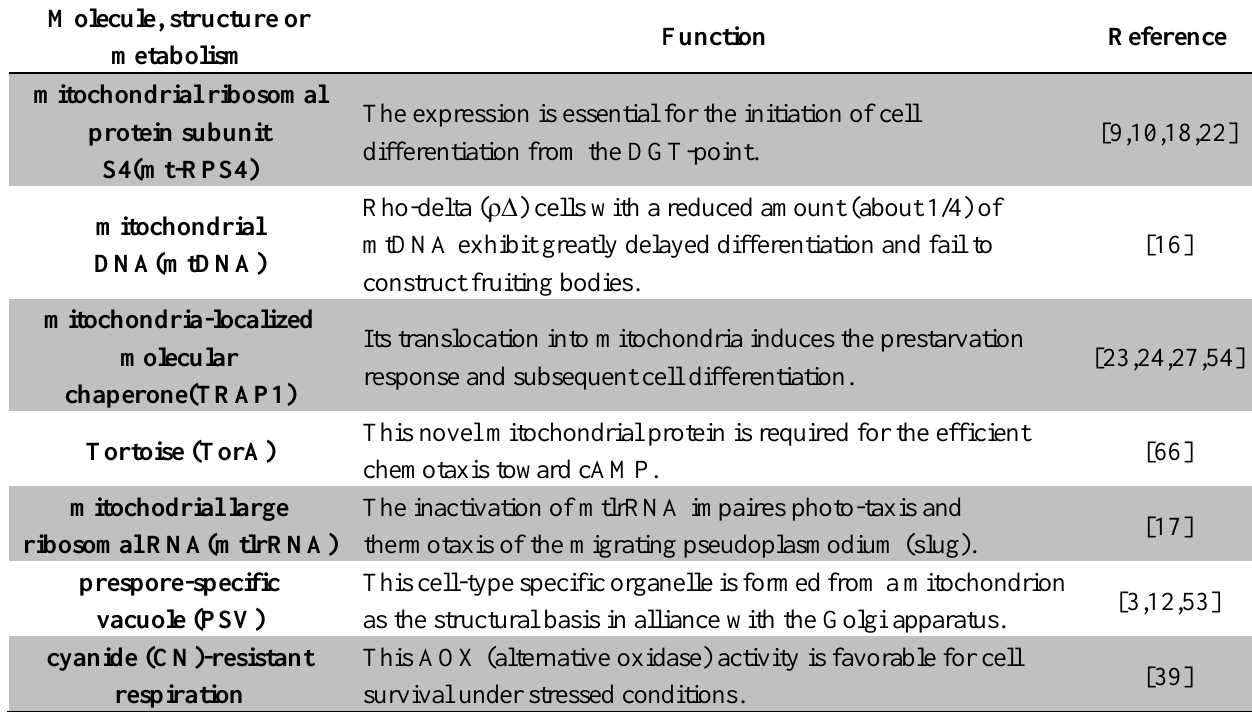
Table 1. Involvements of various mitochondrial functions in Dictyostelium development. Molecule, structure